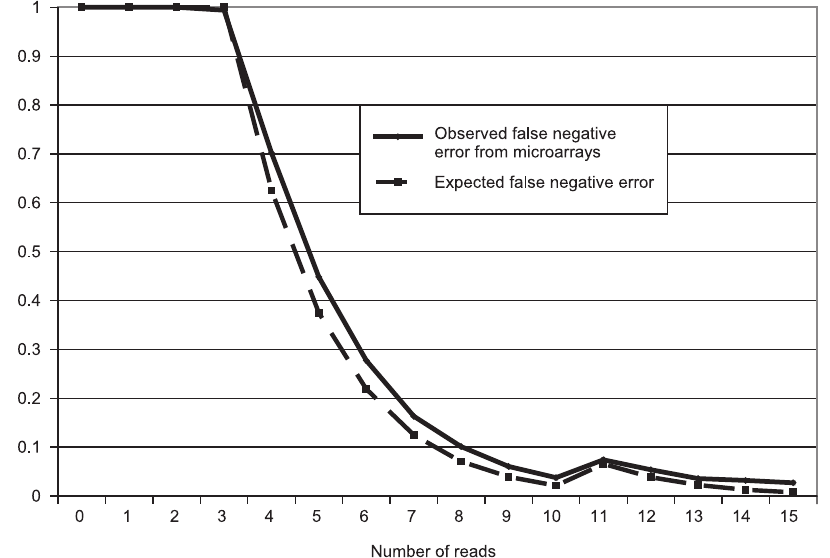
Figure 8. Modeling the Rate of SNP Detection from Microarray Experiments Model of the false-negative rate of heterozygous SNP detection found on Affymetrix or Illumina genotyping platforms in relation to the number of supporting reads found in the HuRef assembly at these loci. The observed false-negative rate of detected heterozygous SNPs in the HuRef assembly closely follows the modeled rate given a Poisson model. The predicted false-negative error is based on the thresholds of requiring at least 20% of the reads supporting the minor allele, two reads minimum. The increased false-negative error at 11 is due to the increased number of reads required to call the minor allele compared to two reads being required at 4 3 –10 3 coverage. Therefore, at 11 3 –15 3 coverage, three reads are required. The additional read changes the binomial distribution and increases false-negative error (See Materials and Methods).